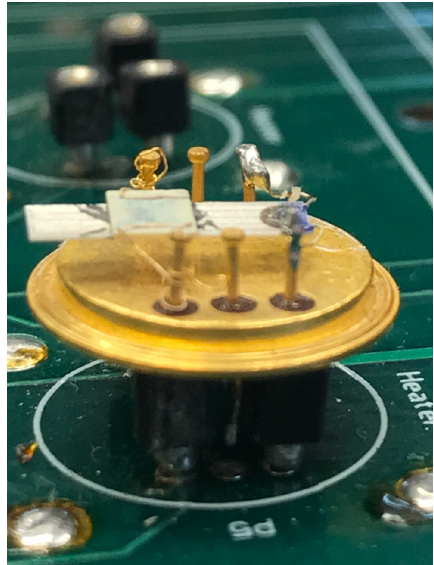
Figure 1. Sensor and heater assembly.